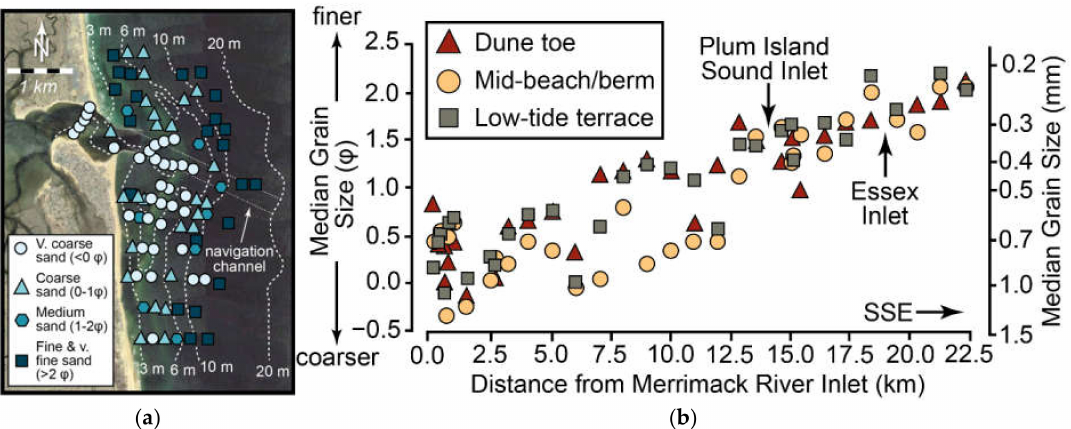
Figure 3. Sedimentological evidence of dominant southerly longshore transport along the Merrimack Embayment. ( a ) Textural trends of bottom grab samples collected from the Merrimack River Inlet ebb-tidal delta. Data from [47]. Background Landsat image: 27 April 2016; ( b ) Fining trend of sediments sampled from the dune toe, berm, and low-tide terrace of beaches from northern Plum Island south across Castle Neck and Coffins Beach. Data from